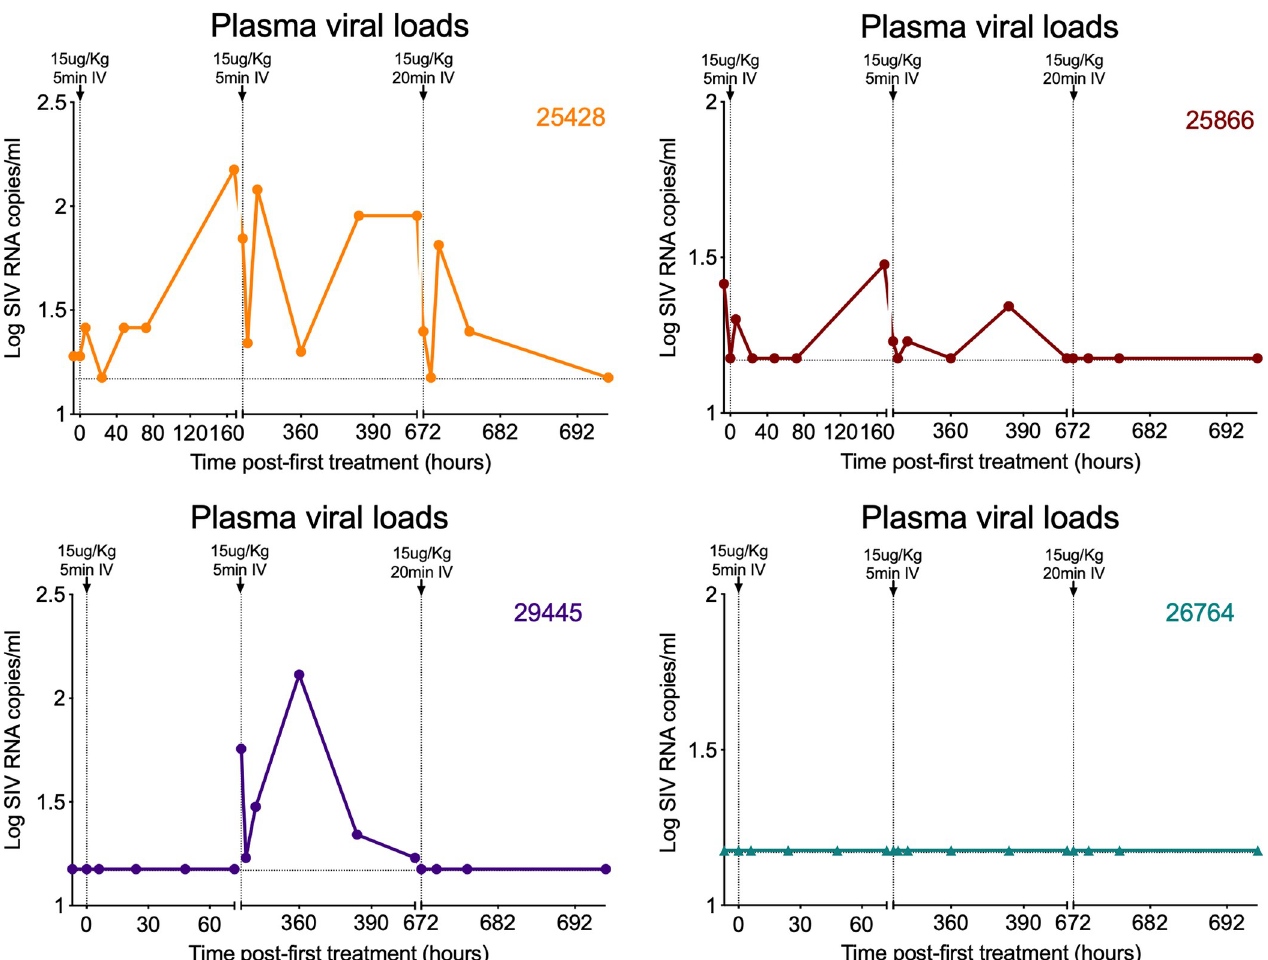
Fig 6. Effects of GSK445A on plasma viral loads. Plasma viral loads profiles of 4 RM following 3 infusions of GSK445A at 15 μ g/kg. Limit of detection was 15 RNA copies/ml of plasma.